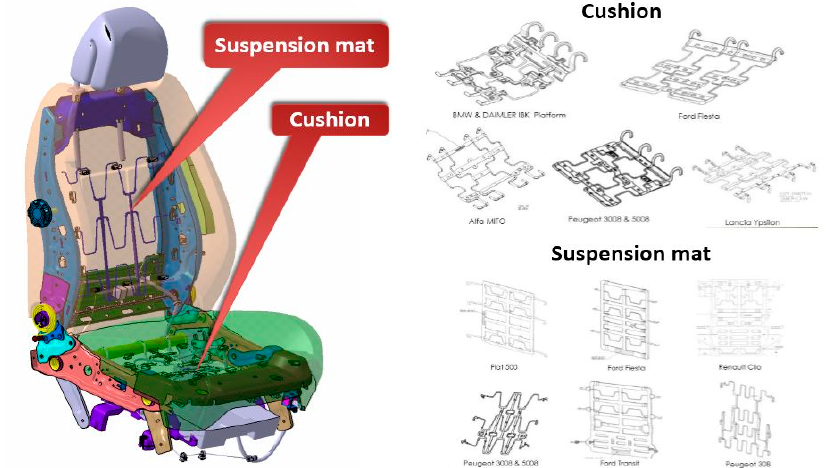
Figure 2. Cushions and suspension mats in an automotive seat. Plastic over-injection machines work with one mold and a half-mold, i.e., the parting plane is horizontal, the mold opens under a vertical axis, the upper part is single (male), while the lower part (female) is twinned. These twinned lower parts of the mold are assembled in a sliding worktable. Thus, while the machine is over-injecting in one of the lower half-molds, the other lower half-mold is being fed with wires or is being unloaded. This can be seen in Figure 3.